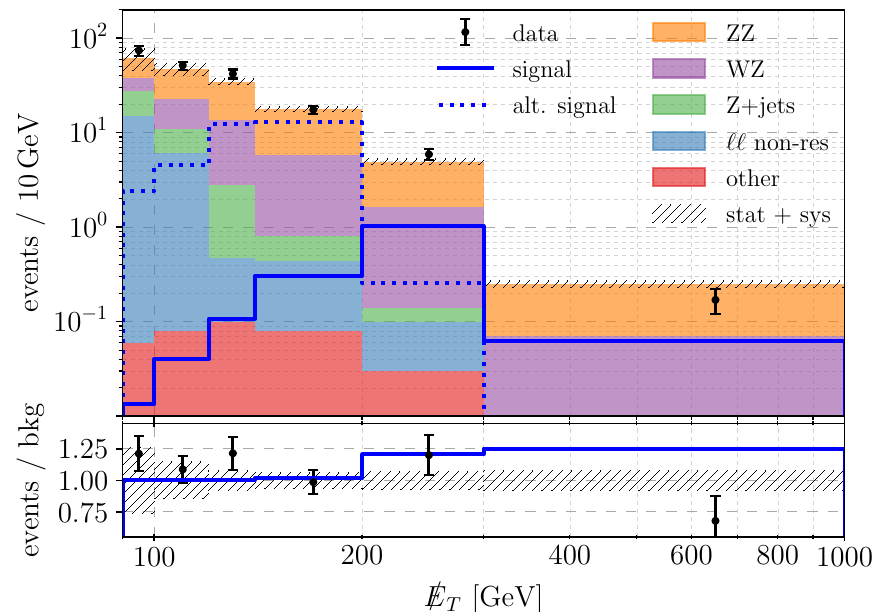
Figure 8 . Top panel: =E spectra for gg ! e + e (cid:0) (cid:31) (cid:22) (cid:31) in the 2HDM+PS for M a = 250 GeV, T M A = 700 GeV (solid line) and M a = 150 GeV, M A = 400 GeV (dotted line), while the other parameters are set to the values given in eq. (4.4). The expected SM backgrounds and observed events are taken from [75] and shown in di(cid:11)erent colors with their combined uncertainty displayed as a hatched region on top. Lower panel: ratios of the observed events (points with error-bars) and signal + background expectation (solid line) to the background expectation plotted together with the background uncertainty (hatched